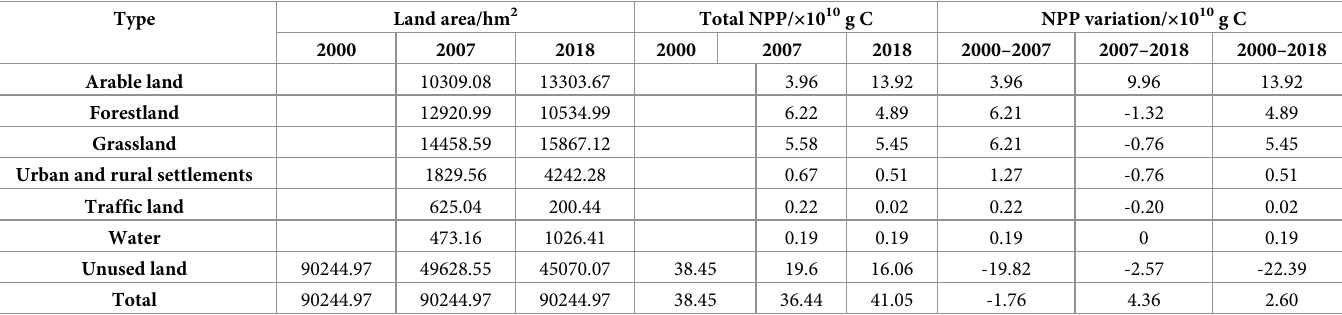
Table 1. Area of different land use types and total NPP and their changes before and after unused land development. Type Arable land Grassland Urban and rural settlements Water Unused land